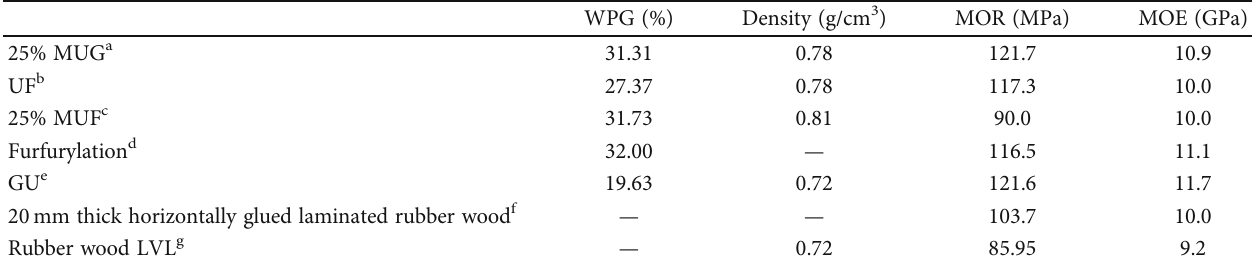
Table 4: The physical and mechanical properties from di ff erent experimental studies of rubber wood. WPG